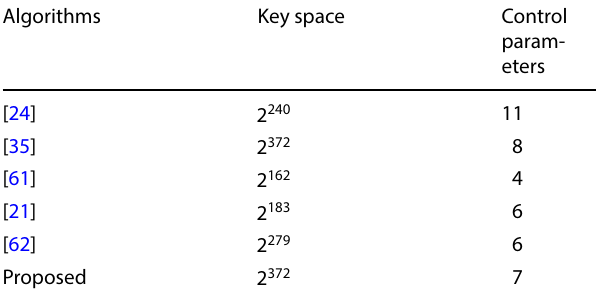
Table 2 Comparison of key space analysis of various algorithms Algorithms Key space